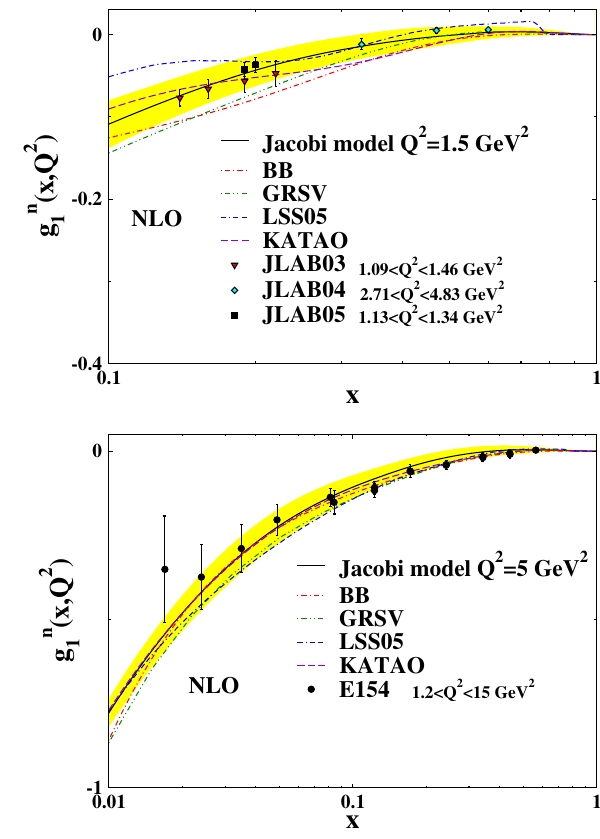
Fig. 5 The spin dependent neutron structure functions as a function of x at Q 2 = 1 . 5 GeV 2 and 5 GeV 2 . The result of Jacobi expansion technique (solid curve) is compared with parametrization models like BB (dashed-dotted) [61], GRSV (dashed-dotted-dotted) [119], LSS05 (dashed-dashed-dotted) [120] and KATAO (dashed) [74]